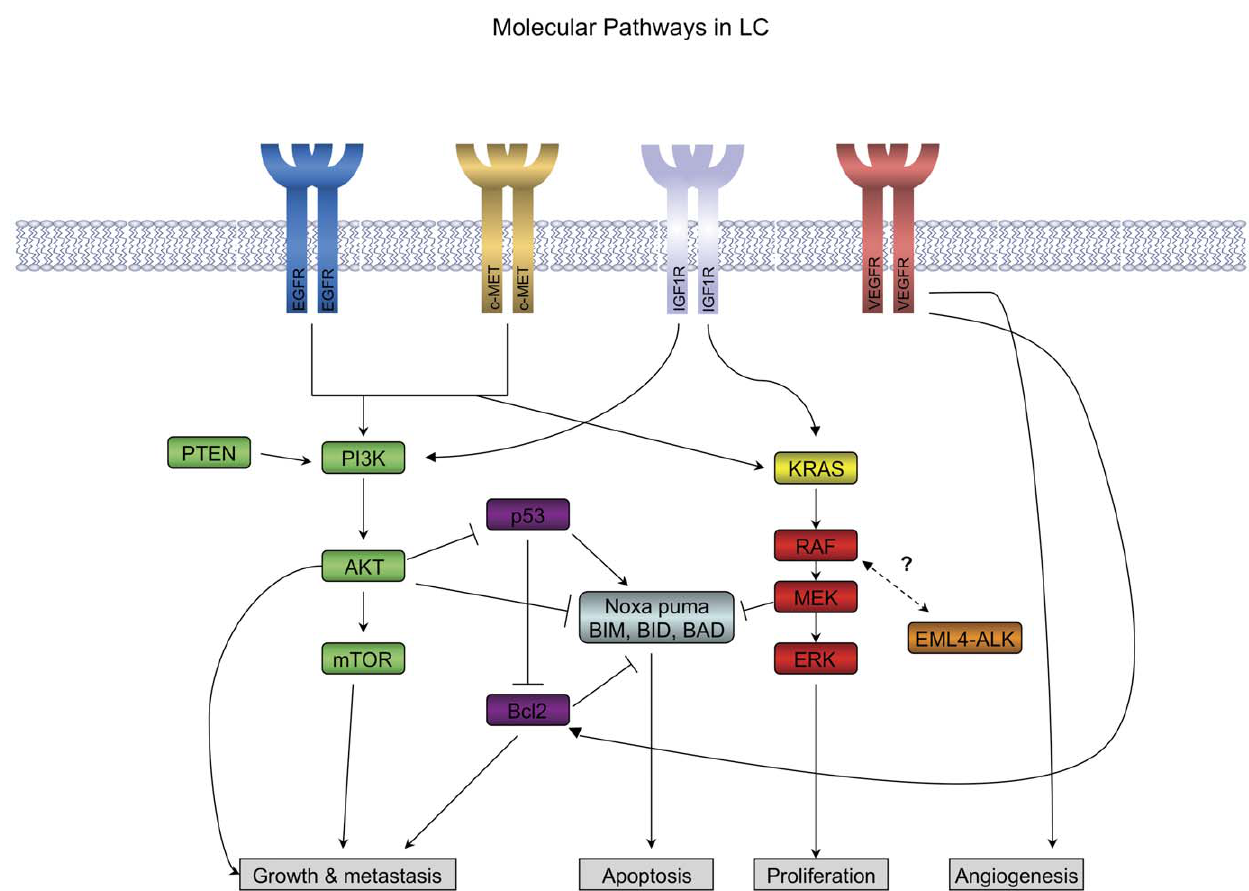
Figure 1. A major signaling pathway implicated in lung cancer is the EGFR pathway which signals to both the AKT/PI3K pathway (green) and the MAPK pathway (red) which regulate cell growth, proliferation and cell death. There is significant cross-talk between these pathways and their downstream effectors, which we have classified into 6 pathways for simplicity to account for differences in treatment modalities. The additional 4 pathways are: EGFR (blue), KRAS (yellow), EML4-ALK (orange), and P53/BCL (purple). It is thought that the RAS/RAF/MEK/ MAPK pathway may be constitutively activated by the EML4-ALK fusion oncogene [100]. The complex relationship between this pathway and EML4- ALK is indicated with a dashed line.